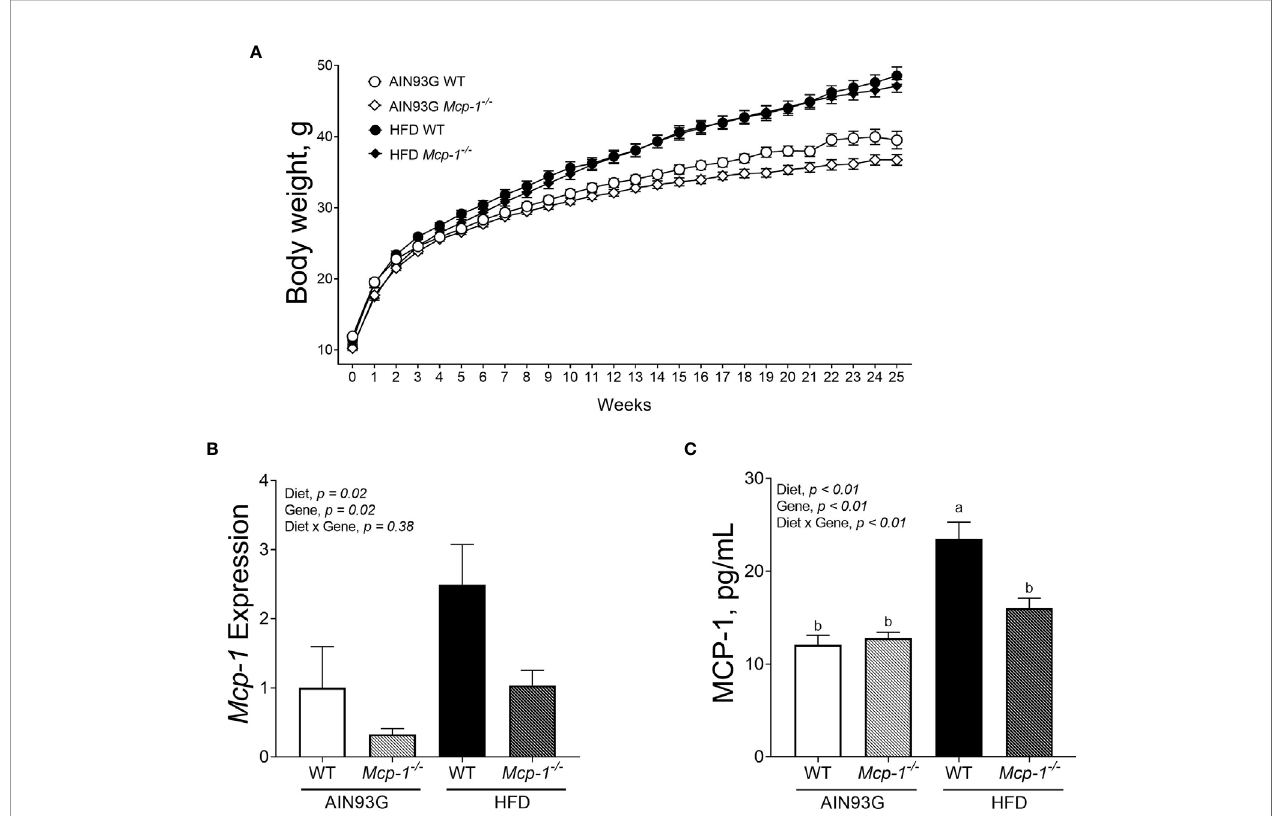
FIGURE 1 | Body weight (A) , adipose Mcp-1 expression (B) , and plasma concentrations of MCP-1 (C) in MMTV-PyMT mice with or without adipose monocyte chemotactic protein-1 knockout [ Mcp-1 -/- or wild-type (WT)] and fed the AIN93G or high-fat diet (HFD). Mice fed the HFD were heavier than mice fed the AIN93G diet; the difference was signi fi cant three weeks after the HFD ( p < 0.05). Mcp-1 -/- mice fed the AIN93G diet were smaller than their WT counterparts; the difference was signi fi cant for the last four weeks of the study ( p < 0.05). Values are means ± SEM [n = 32 per group for WT mice, n = 34 per group for Mcp-1 -/- mice for (A) ; n = 10 per group for (B) ; n = 16 per group for (C) ]. Values with different letters are signi fi cant at p ≤ 0.05 for (C)